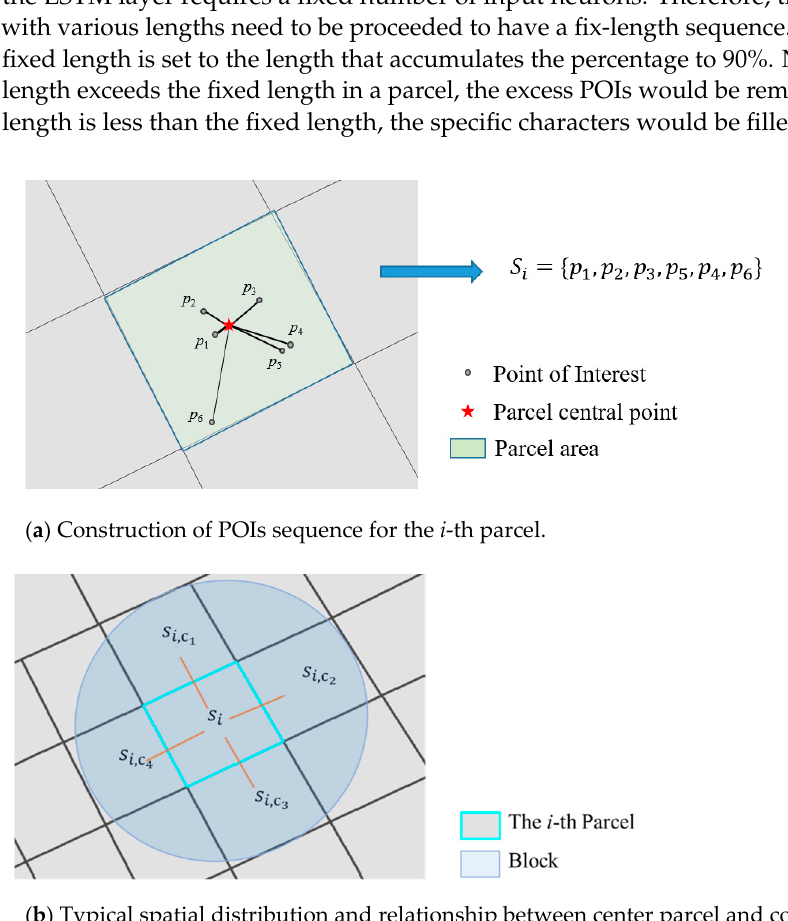
Figure 3. Semantic sequence group for the center parcel S i .